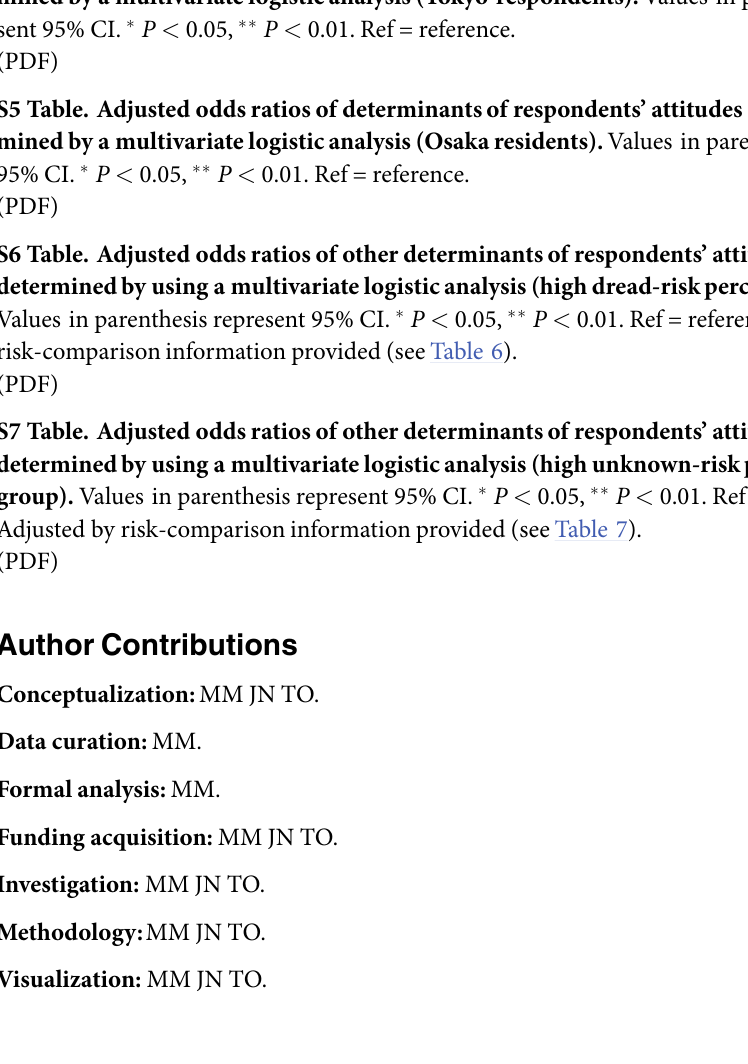
S1 Table. Distributions of respondents’ subjective and objective understanding, perceived magnitude of risk, perceived accuracyof information, backlashagainst information, and risk acceptance. S2 Table. Adjusted odds ratios of other factors affecting respondents’ attitudes to risk, as determined by a multivariate logistic analysis (all respondents). Values in parenthesis repre- sent 95% CI. (cid:3) P < 0.05, (cid:3)(cid:3) P < 0.01. Ref = reference. Adjusted by location including evacuation experience, trust on central government, and risk-comparison information provided (see Table 5). S3 Table. Adjusted odds ratios of determinants of respondents’ attitudes to risk, as deter- mined by using a multivariate logistic analysis (Fukushima respondents). Values in paren- thesis represent 95% CI. (cid:3) P < 0.05, (cid:3)(cid:3) P < 0.01. Ref = reference. S4 Table. Adjusted odds ratios of determinants of respondents’ attitudes to risk, as deter- mined by a multivariate logistic analysis (Tokyo respondents). Values in parenthesis repre-